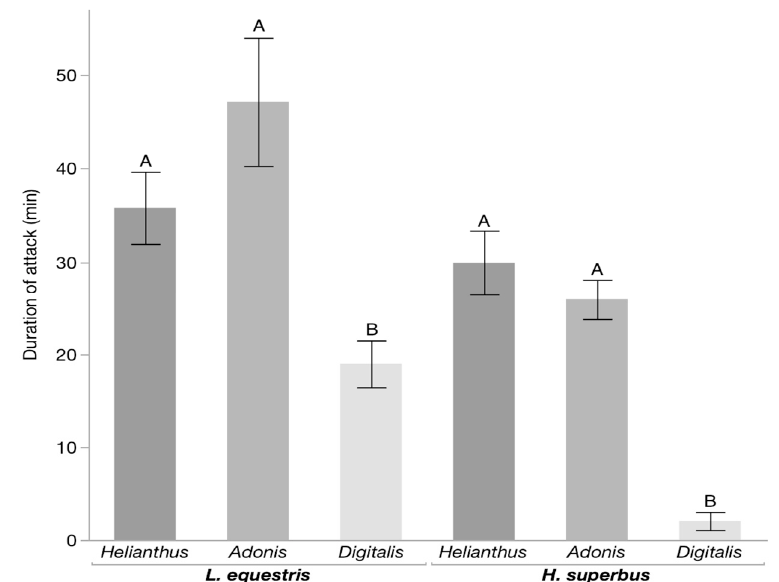
Figure 3. Feeding duration of C. carnea on milkweed bug larvae. Bars represent the means ± SE of the time taken by C. carnea to feed upon L. equestris (n = 22–26 per treatment) and H. superbus (n = 15–16 per treatment) larvae raised on the seeds of either Helianthus annus (sunflower), Adonis vernalis , or Digitalis purpurea . Within the same insect species, different letters above bars indicate significant differences.